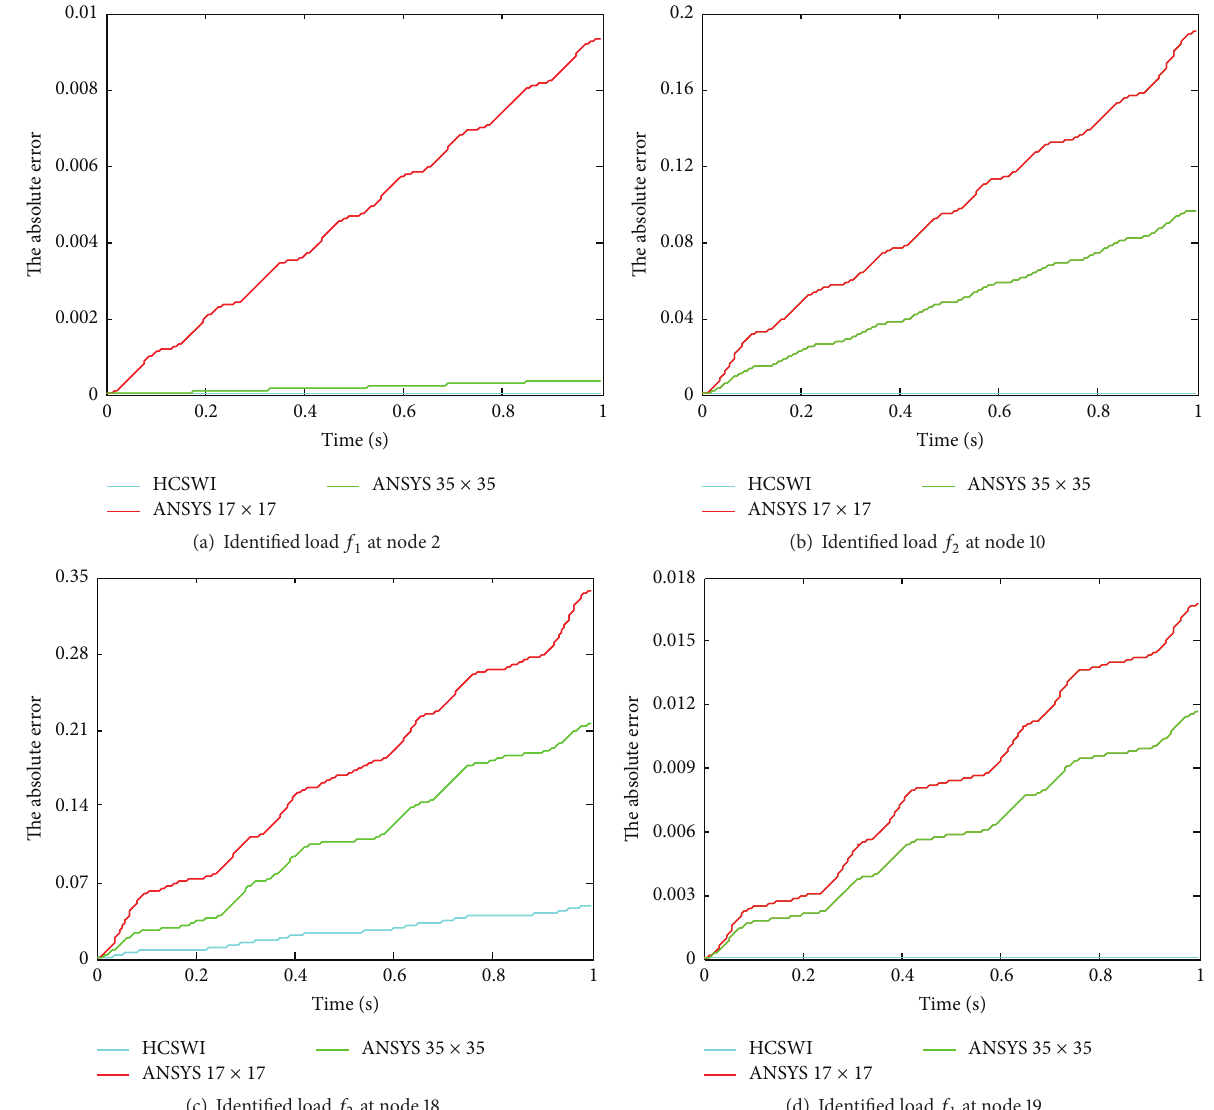
Figure 18: The absolute error with excitation 𝑓 1 and excitation 𝑓 2 applied at nodes 1 and